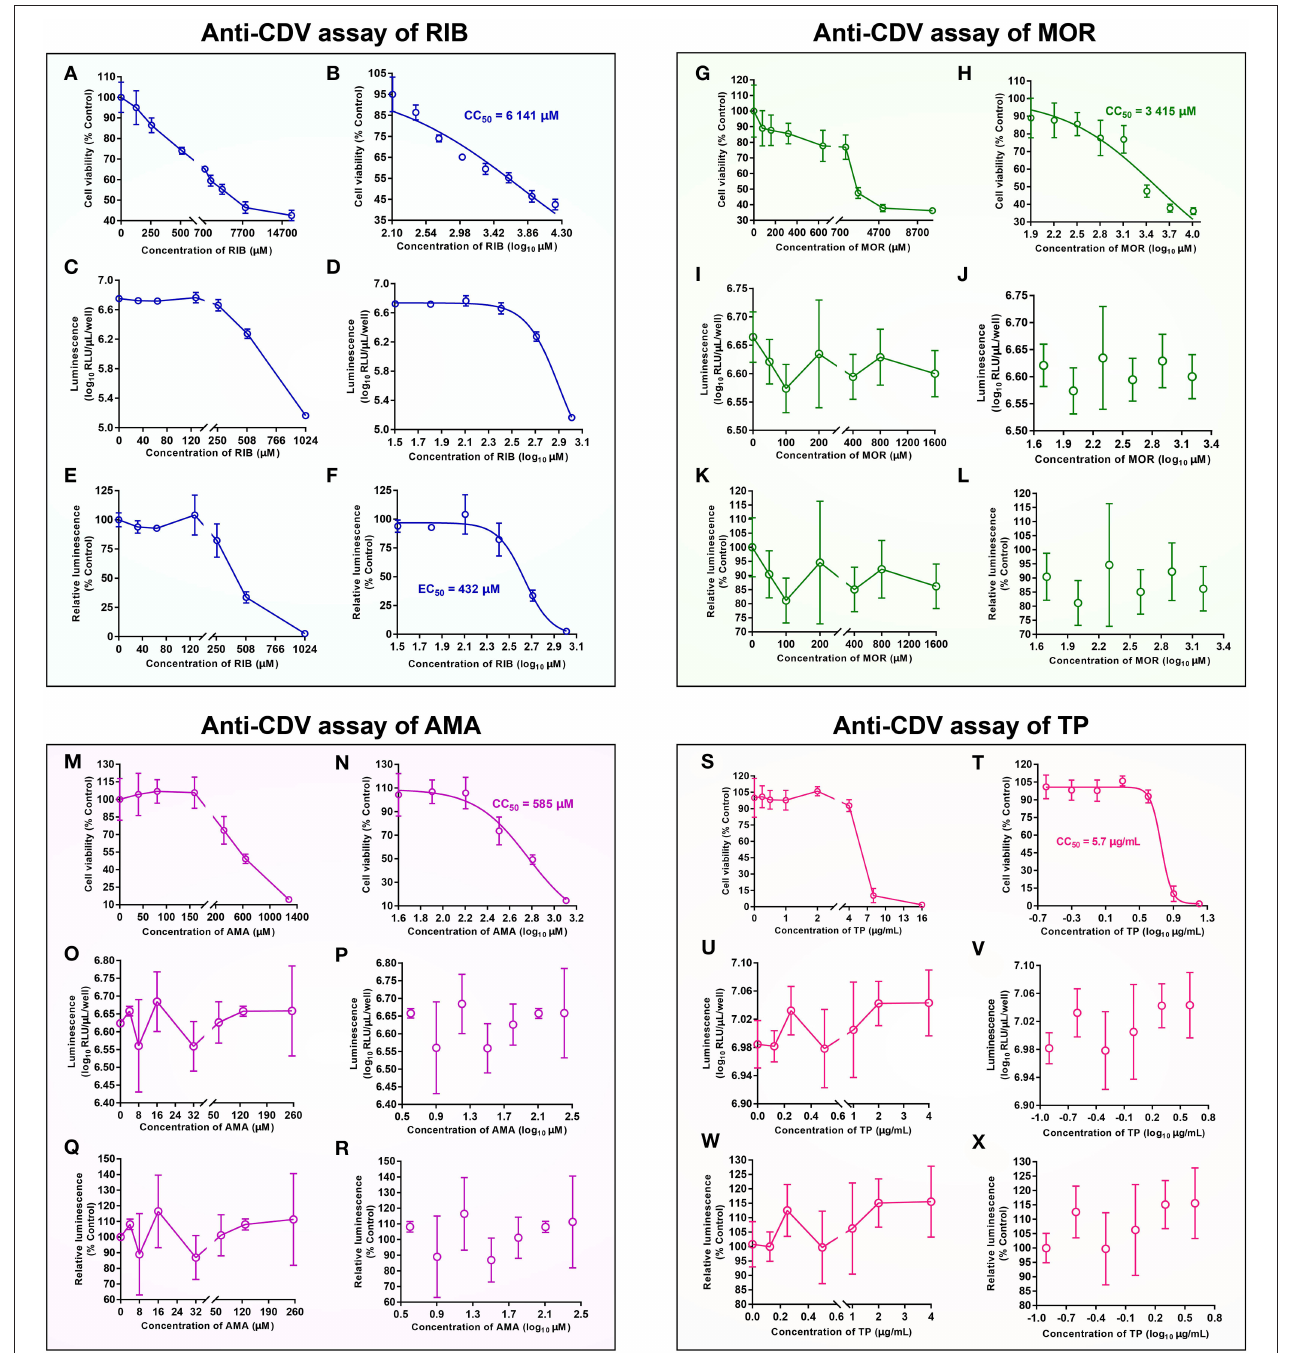
FIGURE 3 | Anti-CDV analyses of ribavirin (RIB) (A–F) , moroxydine hydrochloride (MOR) (G–L) , 1-adamantylamine hydrochloride (AMA) (M–R) and tea polyphenol (TP) (S–X) in vitro . MTT assay on relative viability of VDS cells at 48h after drug treatment at different concentrations (A,G,M,S) . The data represent the mean ± SD for five replicates per dilution. The CC 50 value for a drug, calculated by nonlinear regression fitting using the GraphPad Prism software (B,H,N,T) . Variation of luminescence intensity in rCDV-NLuc-infected VDS cells at 48h after drug treatment with different concentrations (C,I,O,U) . The data represent the mean ± SD for three independent experiments. The data in (C,I,O,U) are processed by nonlinear regression fitting using the GraphPad Prism software, and then shown in (D,J,P,V) . Variation of relative luminescence intensity in rCDV-NLuc-infected VDS cells at 48h after drug treatment with different concentrations (E,K,Q,W) . The EC 50 value for a drug against the rCDV-NLuc, calculated by nonlinear regression fitting using the GraphPad Prism software (F,L,R,X) .